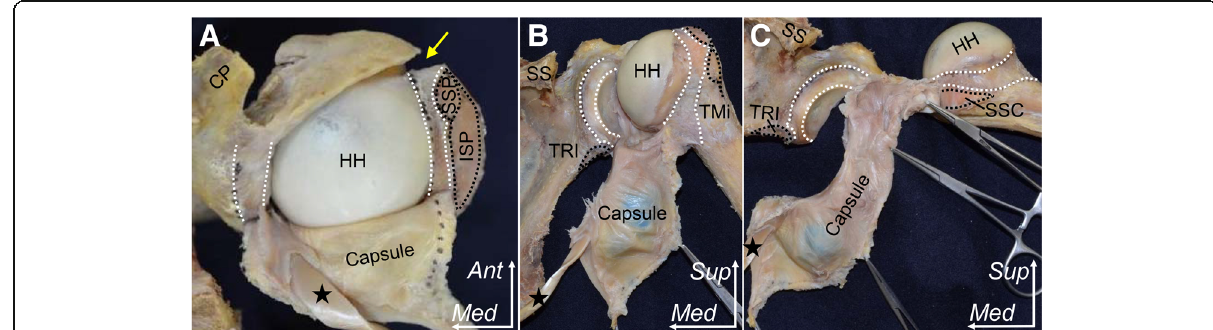
Fig. 3 Detaching the articular capsule from the right shoulder joint. The rotator interval was opened at the anterior edge of the supraspinatus muscle, which is the same site as the lateral edge of the intertubercular groove (yellow arrow). The articular capsule including the labrum with the long head of biceps brachii (black star) was detached from the glenoid and the humerus in the following order: superior ( a ), posterior ( b ), inferior and anterior parts of the shoulder joint ( c ). Areas marked with white dotted lines indicate attachments of the articular capsule. CP, coracoid process; HH, humeral head; ISP, insertion of infraspinatus; SSC, insertion of subscapularis; SS, scapular spine; SSP, insertion of supraspinatus; TMi, insertion of teres minor; TRI, origin of long head of triceps brachii; Ant , anterior; Med , medial; Sup ,